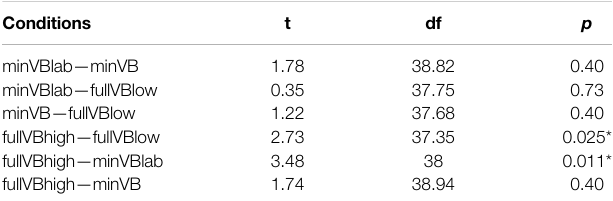
TABLE 4 | Overview of Tukey test comparisons of the ITQ scores. The asterisk denotes a signi fi cant difference. Conditions t df p minVBlab — minVB